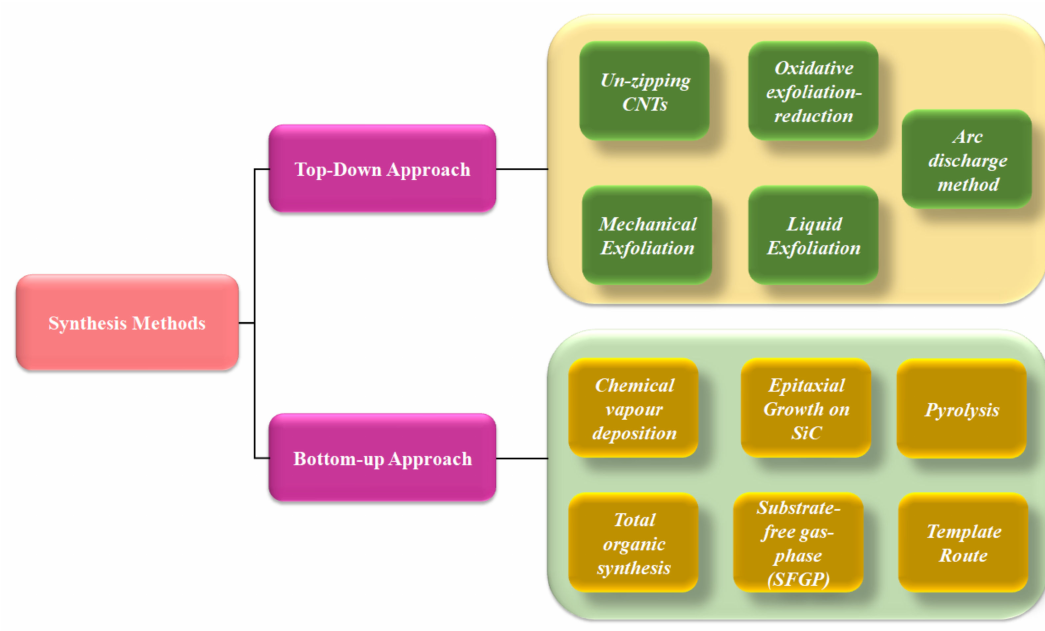
Figure 2. Synthesis approach for